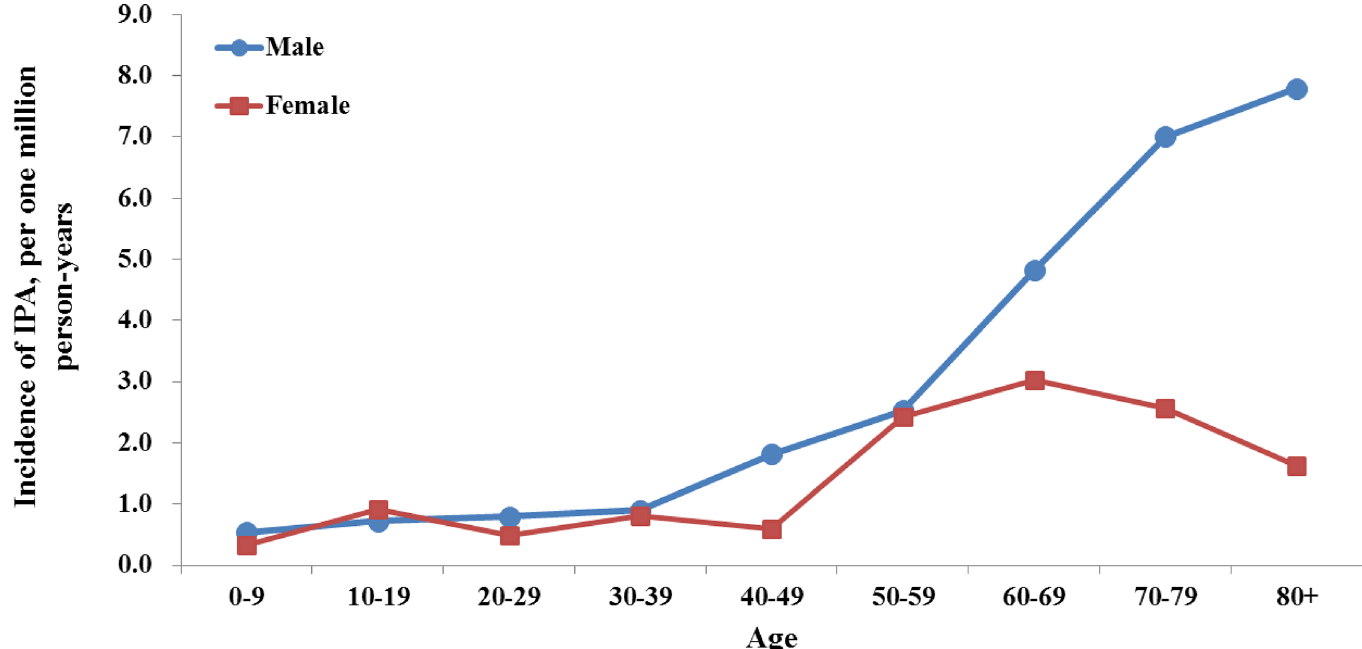
Fig 2. Incidence trend of invasive pulmonary aspergillosis in male and female among different age group.